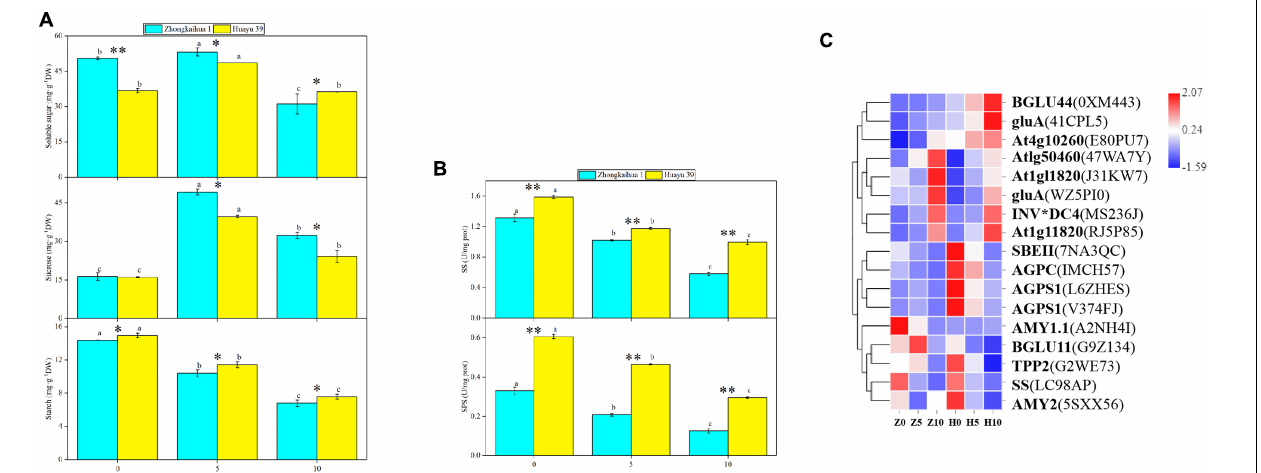
FIGURE 7 | Effects of waterlogging on starch and sucrose metabolism. (A) Effects of waterlogging stress on the soluble sugar, sucrose, and starch contents of leaves. Data represent the mean ± standard error. The measurement was conducted on the leaves of the main stem after treatment. Letters a and b after the value represent statistically significant differences ( p < 0.05) within a variety under different waterlogging treatments as determined by the least significant difference test. Significant differences at * p < 0.05 and ** p < 0.01 between Zhongkaihua 1 (ZKH 1) and Huayu 39 (HY 39) under the same treatment. 0, 5, and 10 represent without waterlogging, waterlogging for 5 days, and waterlogging for 10 days, respectively. (B) Effects of waterlogging stress on the activities of sucrose synthetase (SS) and sucrose phosphate synthetase (SPS). When determining the enzyme activities, the protein concentrations of homogenized leaf samples from different treatments are shown in Supplementary Figure 3 . (C) Expression patterns of the differentially expressed genes (DEGs) induced by waterlogging stress in the starch and sucrose metabolism pathway. Expression change of the DEGs with at least twofold changes and p < 0.05 in the porphyrin and chlorophyll metabolism pathway. The expression levels were calculated in fragment per kilobase per million reads (FPKM) from triplicate experiments. The heat map shows the normalized value Z-score after log2(FPKM) transformation. The color in the heat map represents the Z-score after the transformation of log2(mean FPKM). Each row in the heat map represents the levels of a DEG under different conditions. The DEG name and the gene ID in parenthesis were listed on the right side of the heat map. Abbreviations for DEG encoding proteins: BGLU44, beta glucosidase 43; gluA, lysosomal beta glucosidase-like isoform X1 [Glycine max]; At4g10260, pfkB-like carbohydrate kinase family protein; At1g50460, hexokinase-like 1; At1g11820, glucan endo-1,3-beta-glucosidase 3-like [Glycine max]; INV*DC4, beta-fructofuranosidase 5; SBEII, 1,4-alpha-glucan-branching enzyme-like [Glycine max]; AGPC, glucose-1-phosphate adenylyltransferase family protein; AGPS1, glucose-1-phosphate adenylyltransferase family protein; AMY1.1, alpha-amylase-like; BGLU11, beta glucosidase 11; TPP2, trehalose-6-phosphate phosphatase; SS, sucrose synthase 4; AMY2, alpha-amylase-like